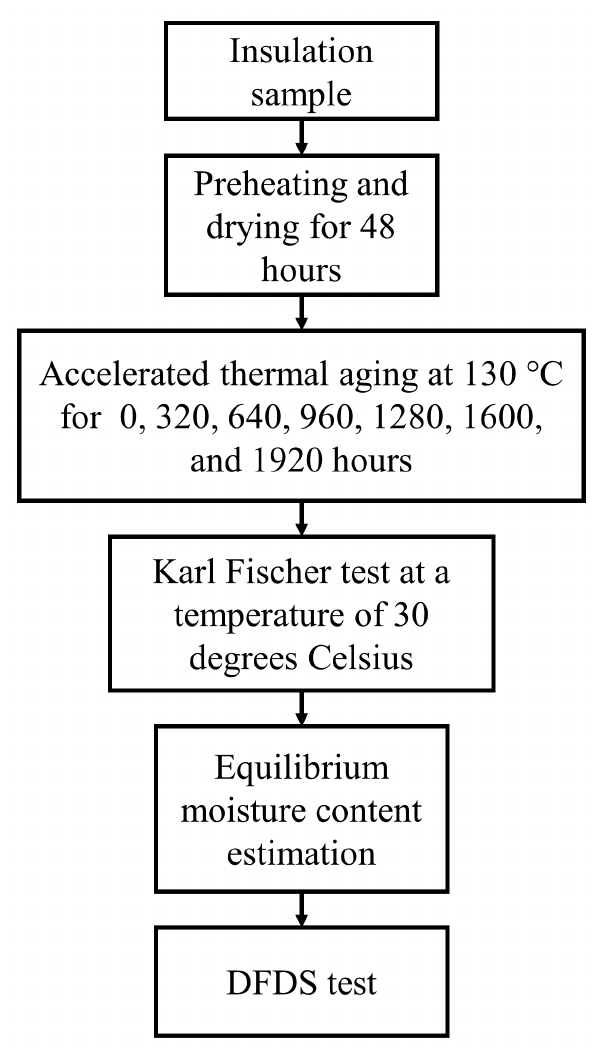
Figure 2. Schematic illustrating the experimental technique.